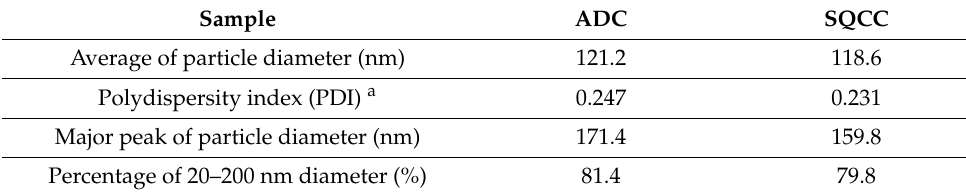
Table 2. Characterization of EV particle diameter.